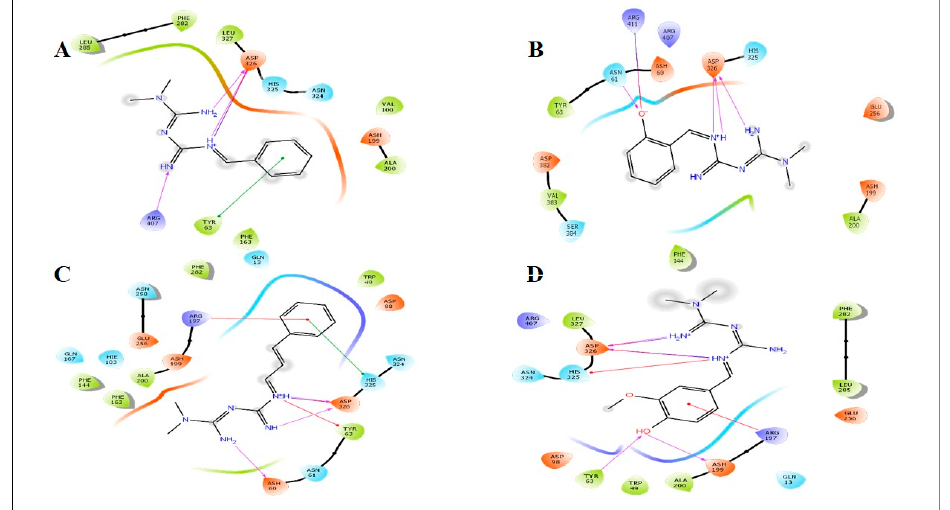
Figure 5. Induced fit docking study of the best pose generated on α -glucosidase (2ZEO): ( A ) Met1 ligand-binding site; ( B ) Met2 ligand-binding site; ( C ) Met3 ligand-binding site; ( D ) Met8 ligand- binding site.